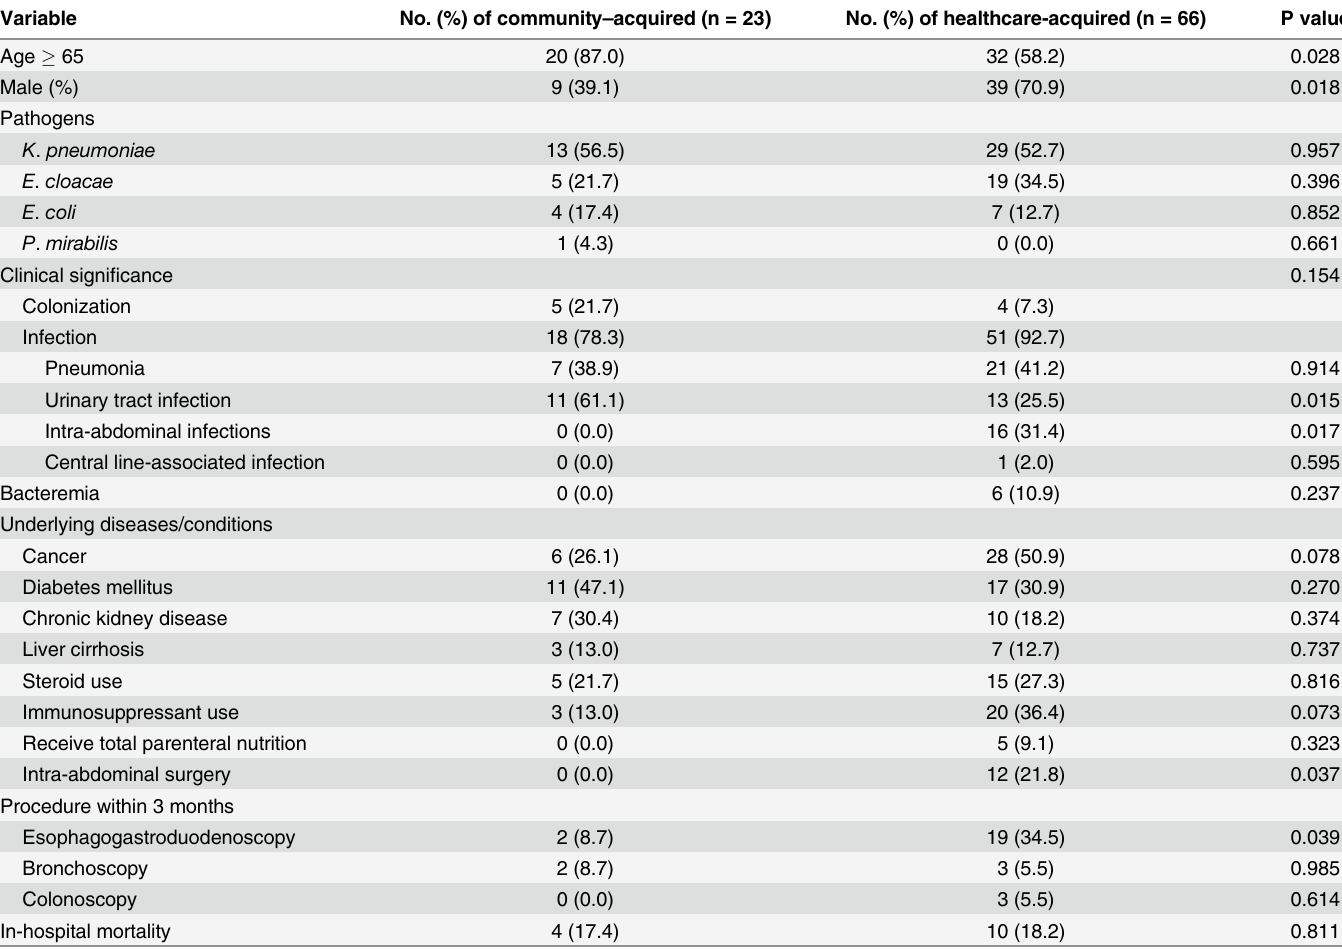
Table 1. Clinical manifestations of 78 patients with clinical isolations of carbapenem-resistant Enterobacteriacae that were acquired from commu- nity or healthcare